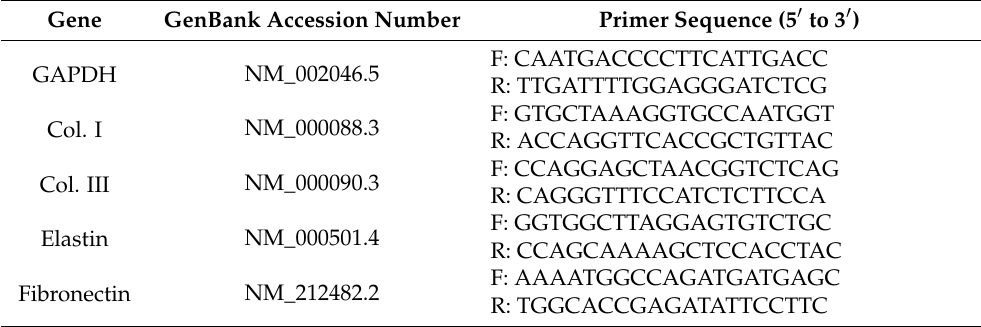
Table 1. Primer sequences of ECM markers and housekeeping gene used in this study.